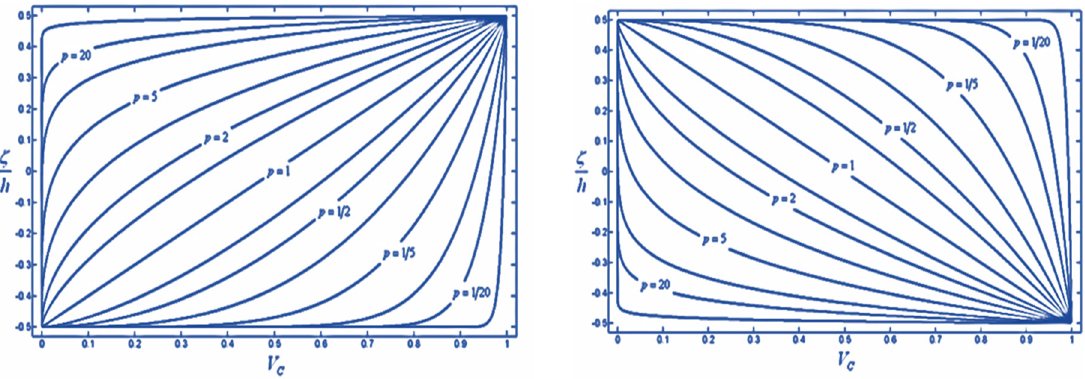
Figure 2. Different volume fraction of ceramic along the thickness for different values of power ‐ law index: ( a ) FGM (Functionally Graded Material) ‐ type 2; ( b ) FGM ‐ type 1 [38].